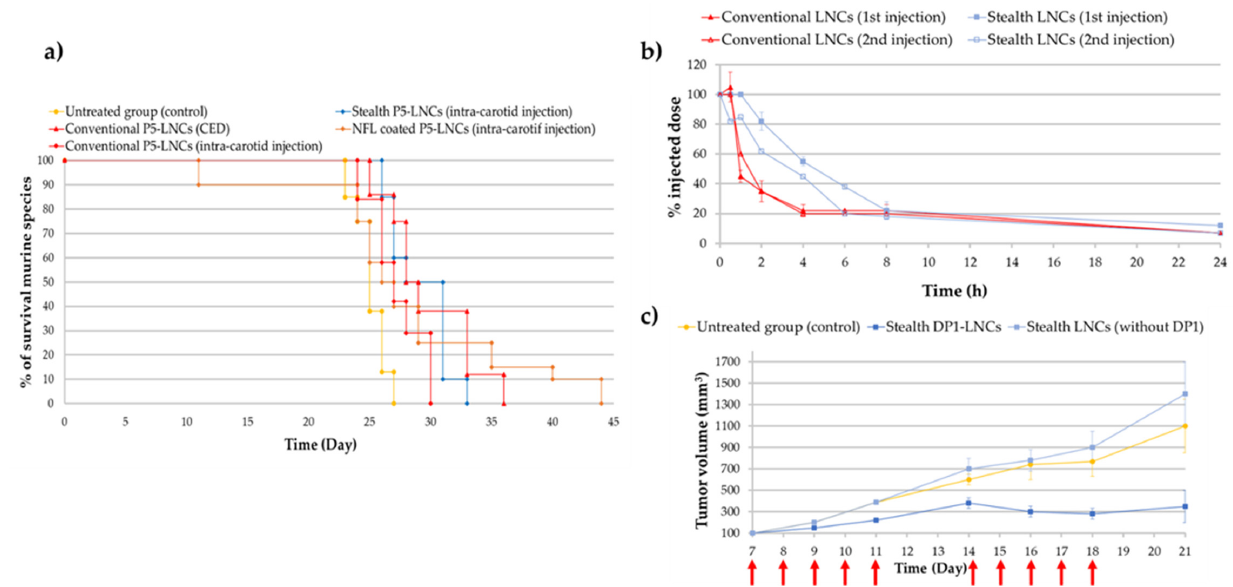
Figure 7. ( a ) Kaplan–Meier survival plots for 9L glioma-bearing rats receiving CED injection of conventional P5-LNCs (red triangle) or intracarotid injection of NFL-coated P5-LNCs (orange diamond), stealth P5-LNCs (blue diamond) and conventional P5-LNCs (red diamond). The red arrow indicates the injection day: day 6 (adapted with permission from [28,97], Copytight 2021 Elsevier); ( b ) ABC phenomenon evaluation of stealth LNCs between the first (blue square) and second injection (unfilled blue square) (adapted with permission from [99], Copytight 2021 Elsevier); ( c ) in vivo treatment efficiency of stealth DP1-LNCs (dark blue square) on ectopic 9L glioma-bearing rats, the red arrows indicated the days of injections (adapted with permission from [99], Copytight 2021 Elsevier).